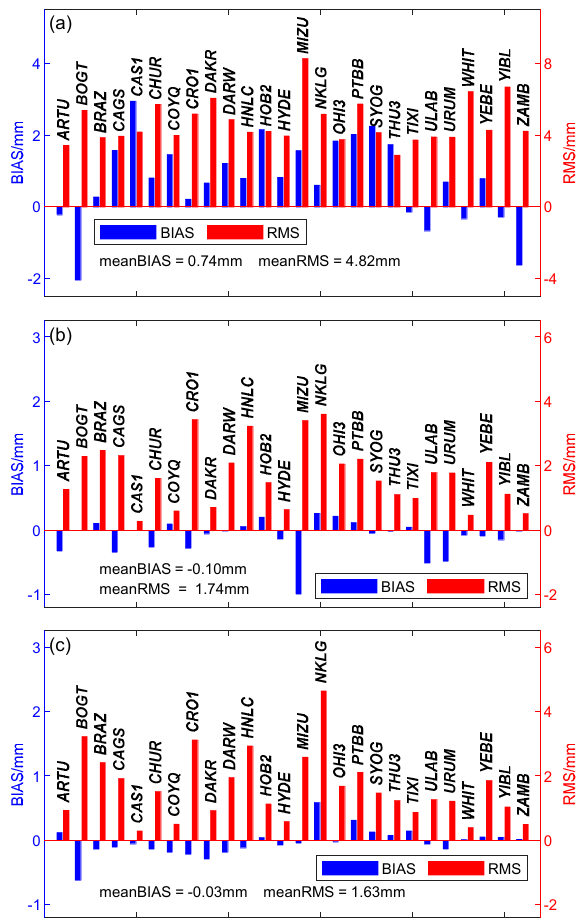
Figure 2. Average deviation (BIAS) (blue) and root mean square (RMS) error (red) of NGL zenith total delay (ZTD) ( a ), gradients in the north direction (Grad.N) ( b ), and gradients in the east direction (Grad.E) ( c ), with data span from January 2009, to April